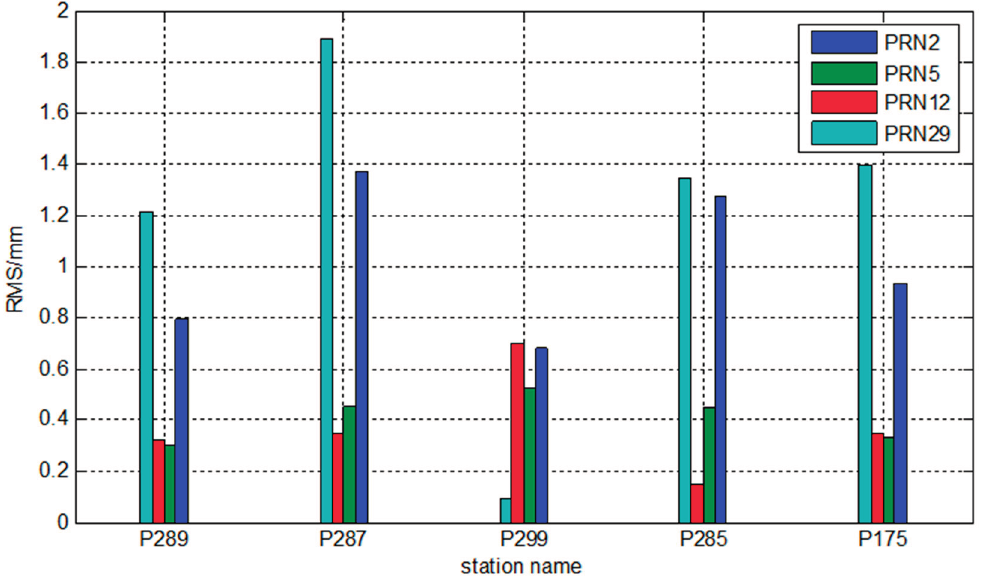
Figure 3. Statistical RMS values of the OMC vector of observation equations in different